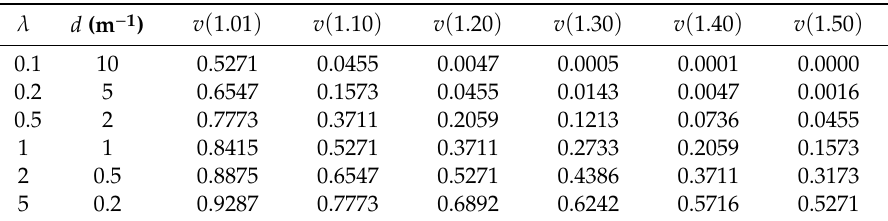
Table 5. Dimensionless displacements v ( x ) of the free